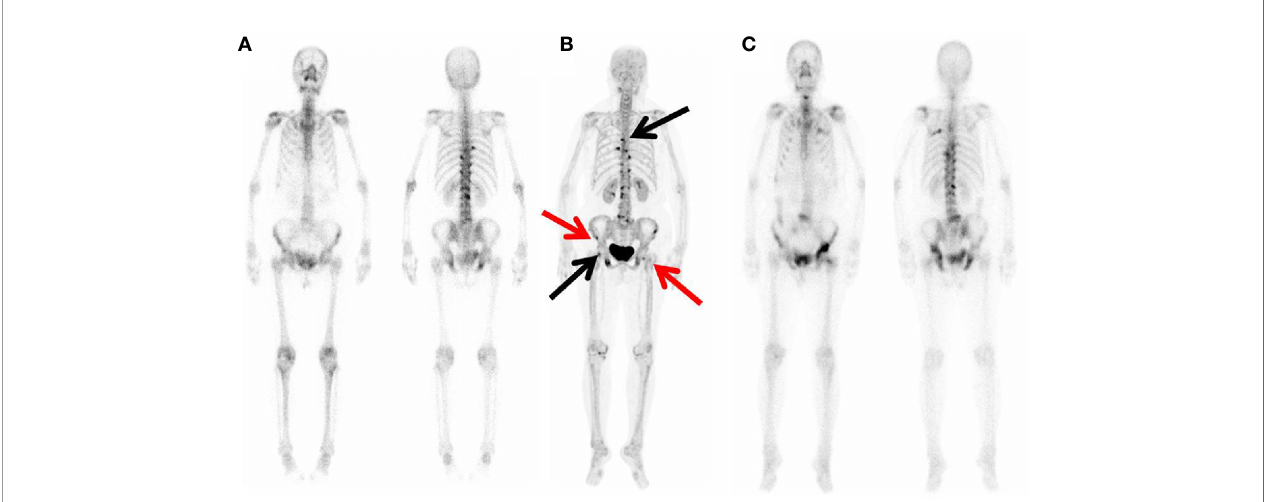
FIGURE 3 | 99m Tc-MDP WBBS and 68 Ga-P15-041 MIP in a 72 y patient with Left lung adenocarcinoma. (A) 99m Tc-MDP WBBS showed multiple high uptake in right 8th rib, left 9th rib, left ilium, bilateral pubic, and thoracolumbar. (B) MIP of 68 Ga-P15-041 showed more high uptake lesions (black and red arrow). (C) 99m Tc- MDP WBBS after one year later showed disease progression, and right ilium and left femur (black arrow) showed new high uptake.